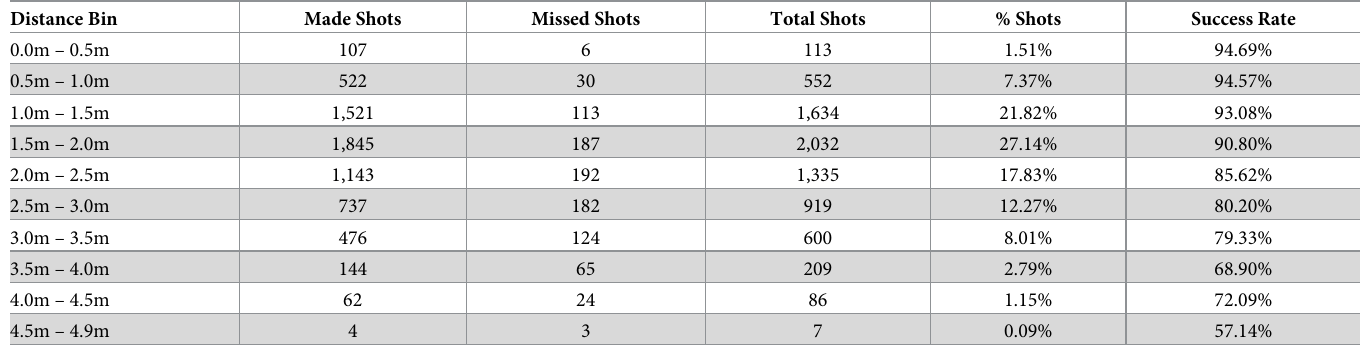
Table 1. Total number of made, missed, total shots and proportion (%) of all shots, and the success rate from distance bins at 0.5m intervals from the goal post. Distance Bin